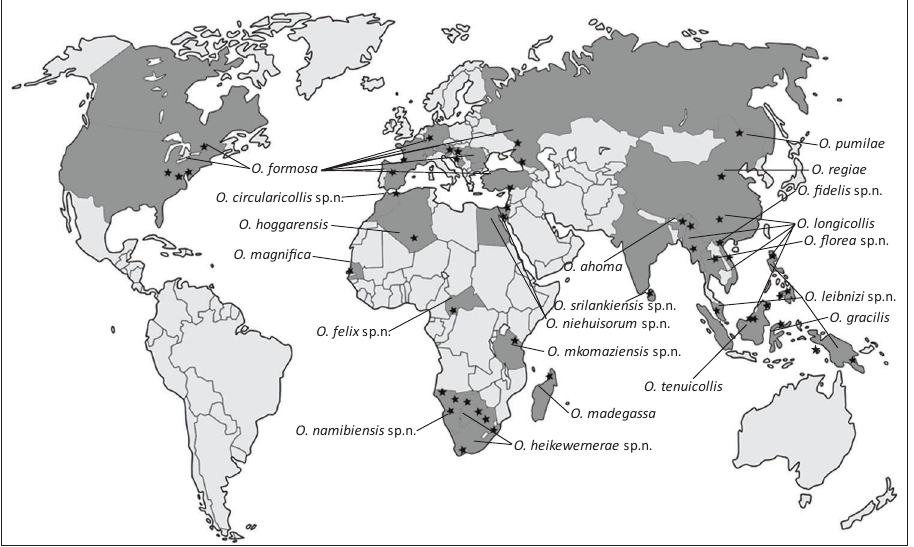
Figure 17. Geographic distribution of the genus Oodera . Countries from which Oodera was recorded are highlighted in dark grey. Stars indicate record localities. Record localities of O. pumilae Yang and O. regiae Yang are not exact but placed in the centre of the respective Chinese province from which the species was